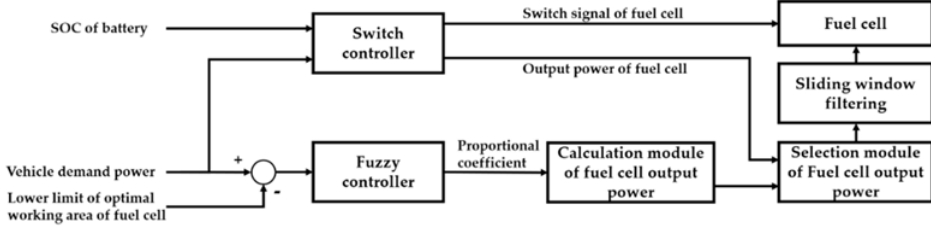
Figure 5. Flow chart of the composite fuzzy energy management strategy.